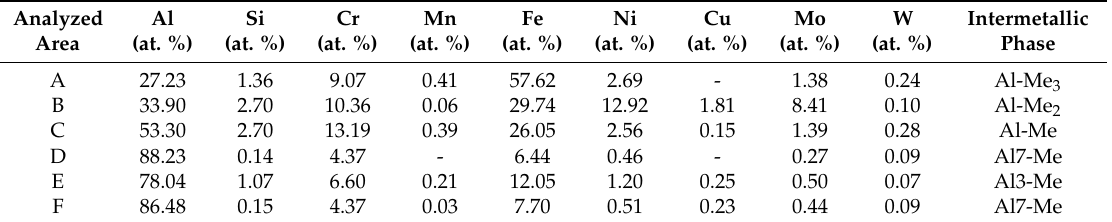
Table 4. Chemical composition (at. %) measured through SEM/EDS in the marked areas, highlighted in Figure 11, of the sample annealed at 1080 ◦ C for 72 s/mm and aluminized at 1100 ◦ C for 2700 s. Analyzed